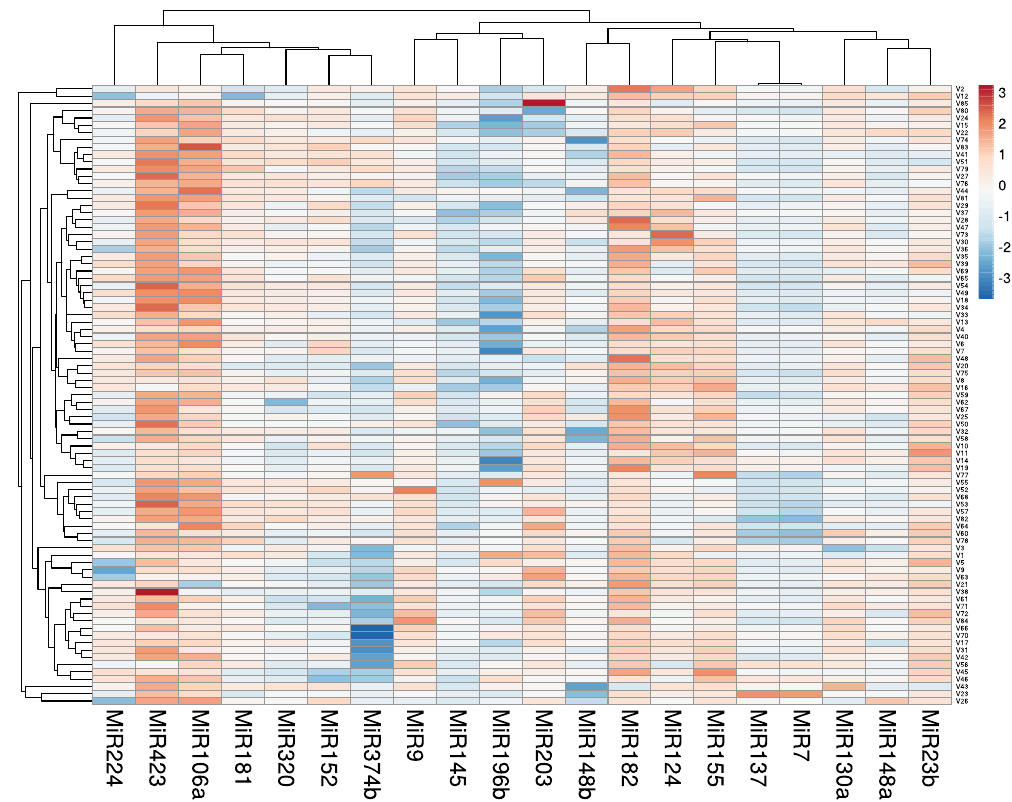
Figure 1. The differential expression profile of circulating miRNAs understudy in vitiligo (n = 85). Heat map illustrates the levels of all miRNAs understudy (Log2fold change) in vitiligo patients. Color grades are shown within each row, with the highest expression corresponding to deep red and the lowest to deep